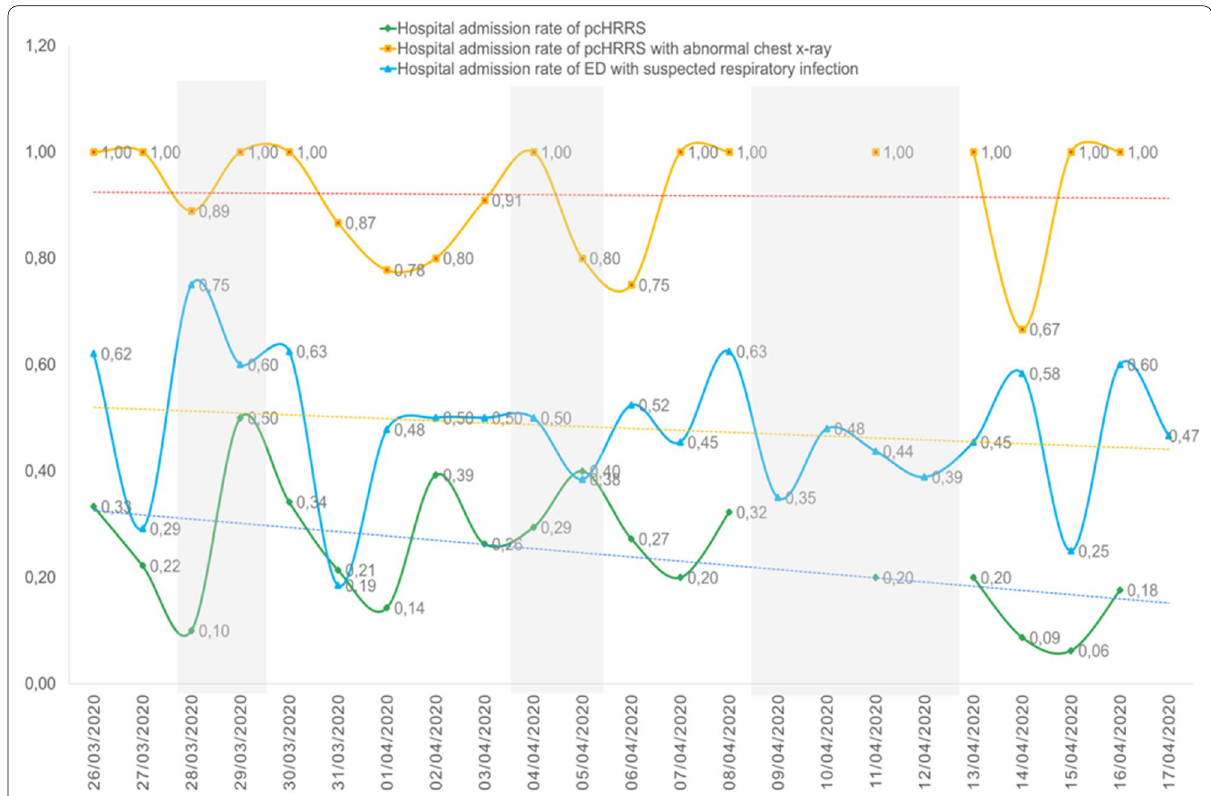
Fig. 5 Daily hospital admission rate for the different groups: patients seen through the primary care high-resolution radiology service (pcHRRS, green line), those arriving to the emergency department (ED, blue line) by themselves, and those seen through the pcHRRS but later referred to the ED due to pneumonia findings (yellow line). Grey bands correspond to holidays, when despite being operational, patients were less appointed for a pcHRRS. On March 9th, no patient was appointed for a pcHRRS; on March 10th and 12th, pcHRRS patients did not require